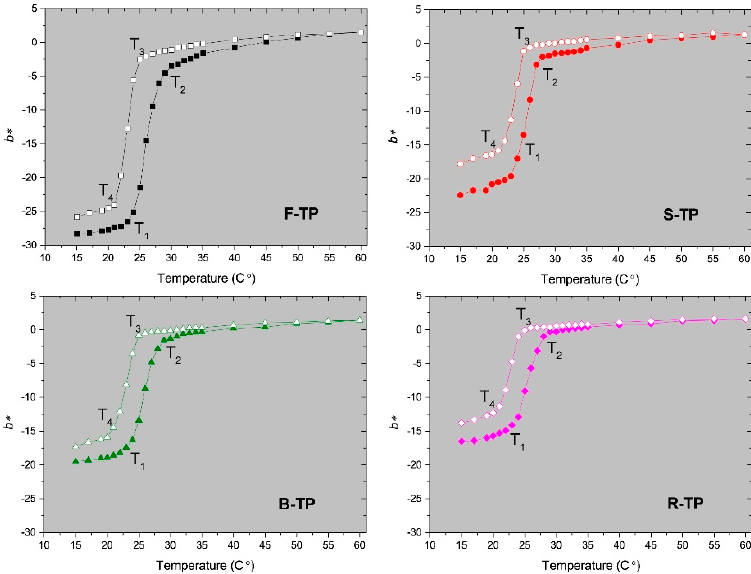
Figure 4. CIELAB b* of TC ink printed on filter (F-TP), synthetic (S-TP), bulky (B-TP), and recycled paper (R-TP) in dependence of temperature; heating-solid signs, and cooling-open signs.